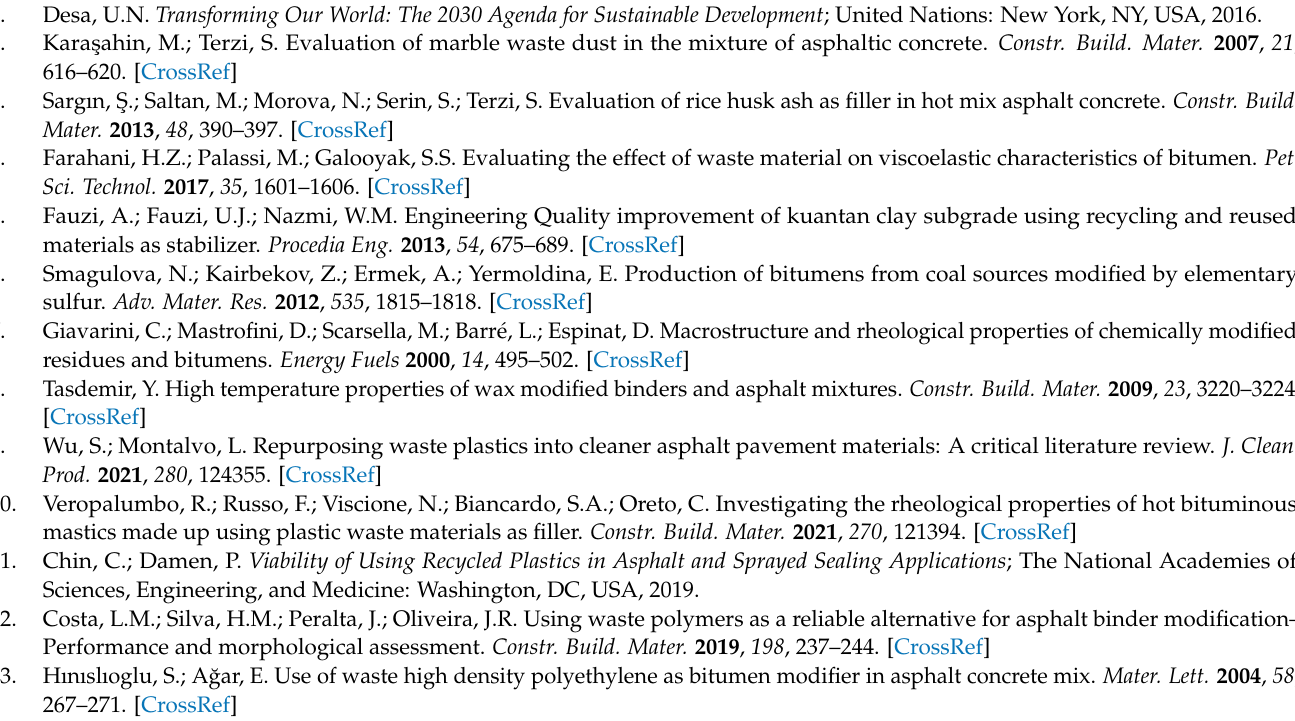
Table S2: Normalized engineering performance and environmental indicators for matrix N1 for binder course and N2 for base layer. Table S3: Percentage weight assigned to each indicator for the initial weight configuration and the additional 24 weight configurations of sensitivity